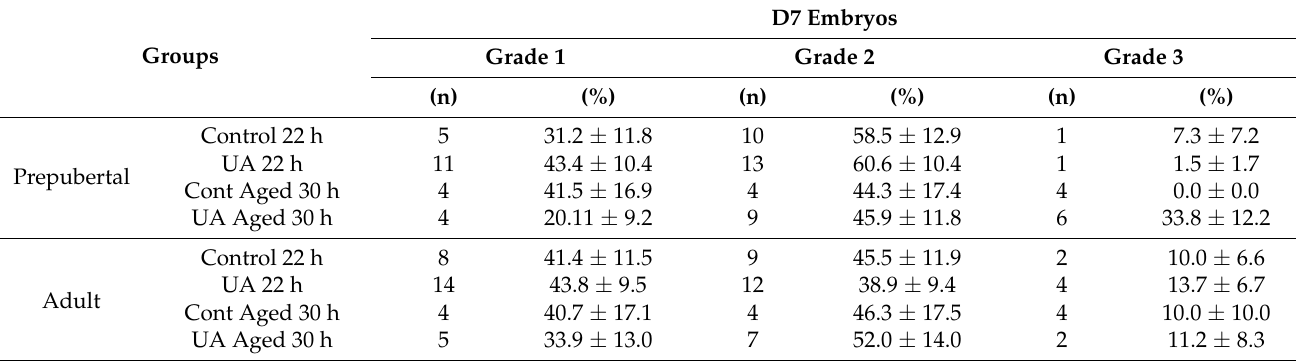
Table 3. Effect of the maturation medium supplementation with Urolithin A (UA), cumulus-oocyte complexes (COCs) aging and female age on the number and quality of the produced embryos. The embryo quality was classified based on morphological criteria as excellent/good (Grade 1), fair (Grade 2) and poor (Grade 3). Prepubertal: control 22 h, UA 22